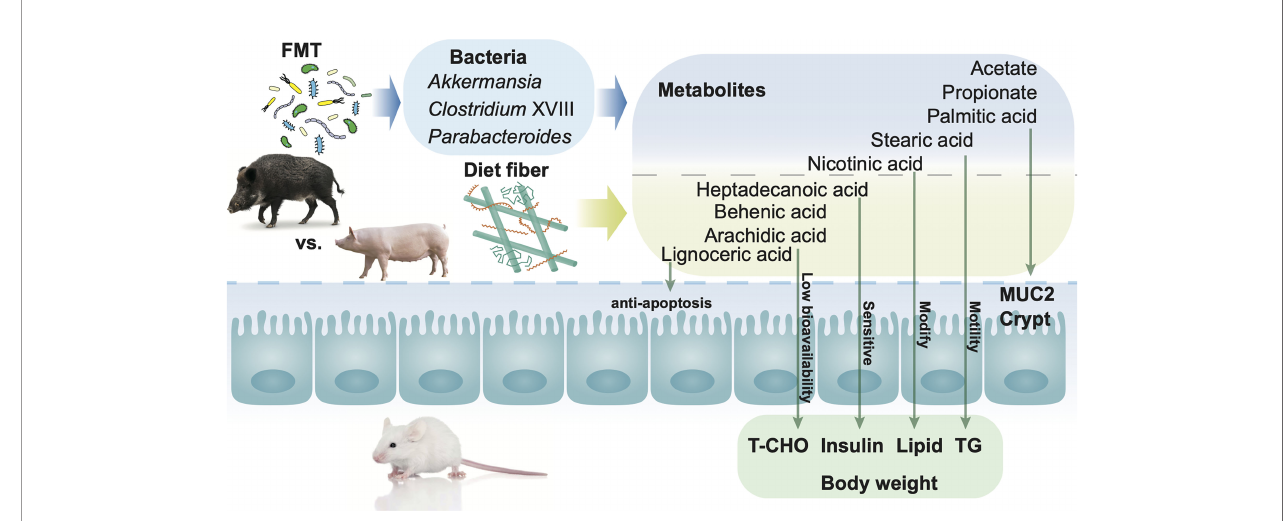
FIGURE 7 | Mechanisms of fecal microbiota transplantation (FMT) together with dietary fi ber intervention contribute to the alteration of metabolites in the gut, leading to modi fi cation of gut barrier function and serum characteristics in mice. Both FMT and dietary fi ber intervention contributed to the alteration of the host health, via metabolites in the gut. Dietary intervention with high fi ber led to the alteration of metabolites such as lignoceric acid, behenic acid, arachidic acid, and heptadecanoic acid in the gut. Mice FMT from wild pigs together with a high fi ber diet showed a higher abundance of Akkermansia , Parabacteroides , and Clostridium XVIII in the gut. The alteration of metabolites together with bacteria in the gut plays an important role in the improvement of mucus barrier function as well as the decrease in body weight, total cholesterol (TC), and